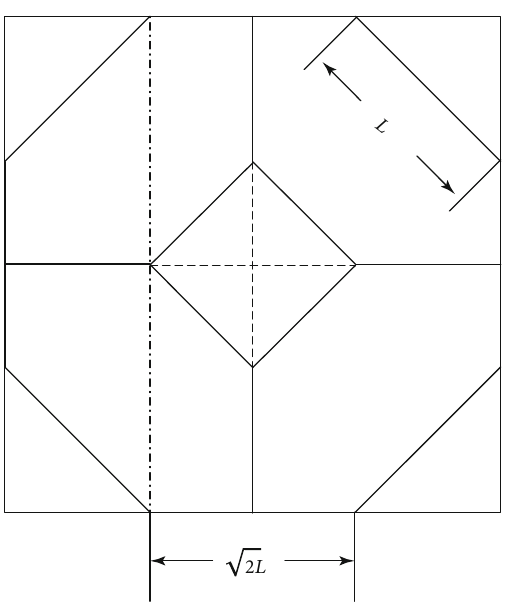
Figure 5: Aperture analysis